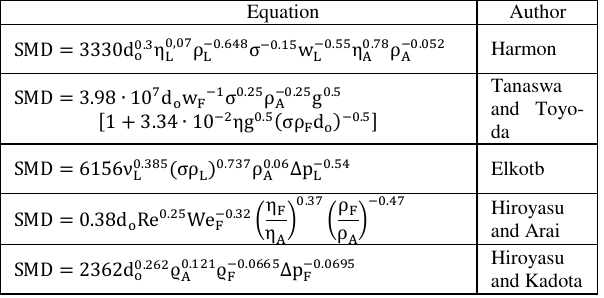
Table 1. Calculation formulas for determining the mean diametre of a drop [5] Equation Author